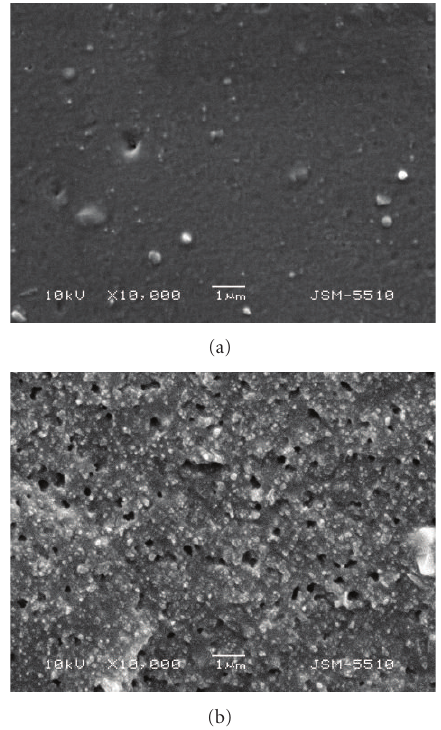
Figure 2: SEM micrograph of a non-unfilled composite (a) and a composite, containing 1.5phr of fullerene (b).